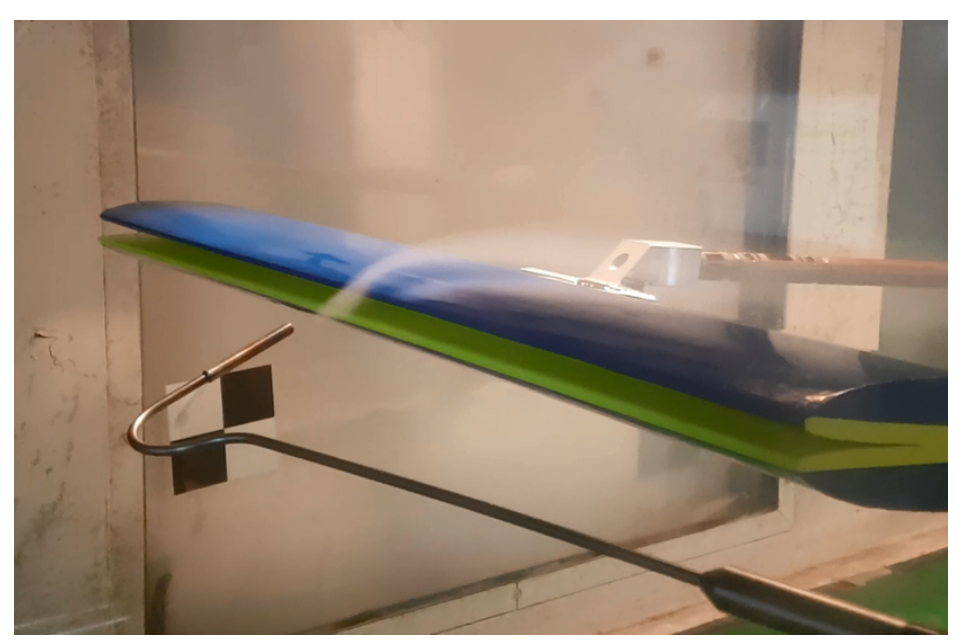
Figure 26. Smoke aided wind tunnel test result on a G2A30.7